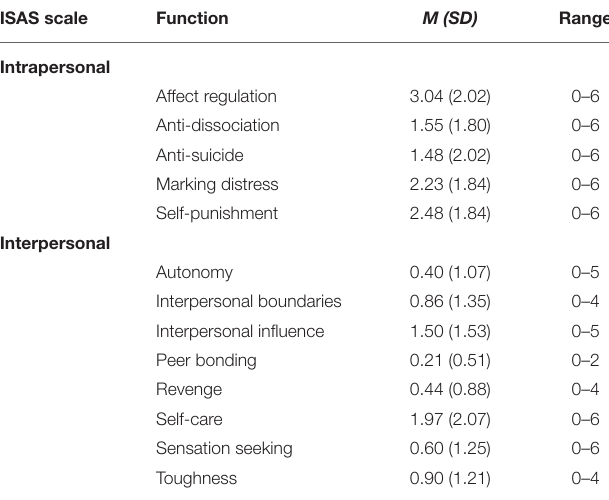
TABLE 4 | Functions of NSSI (mean ISAS values) in forensic psychiatric